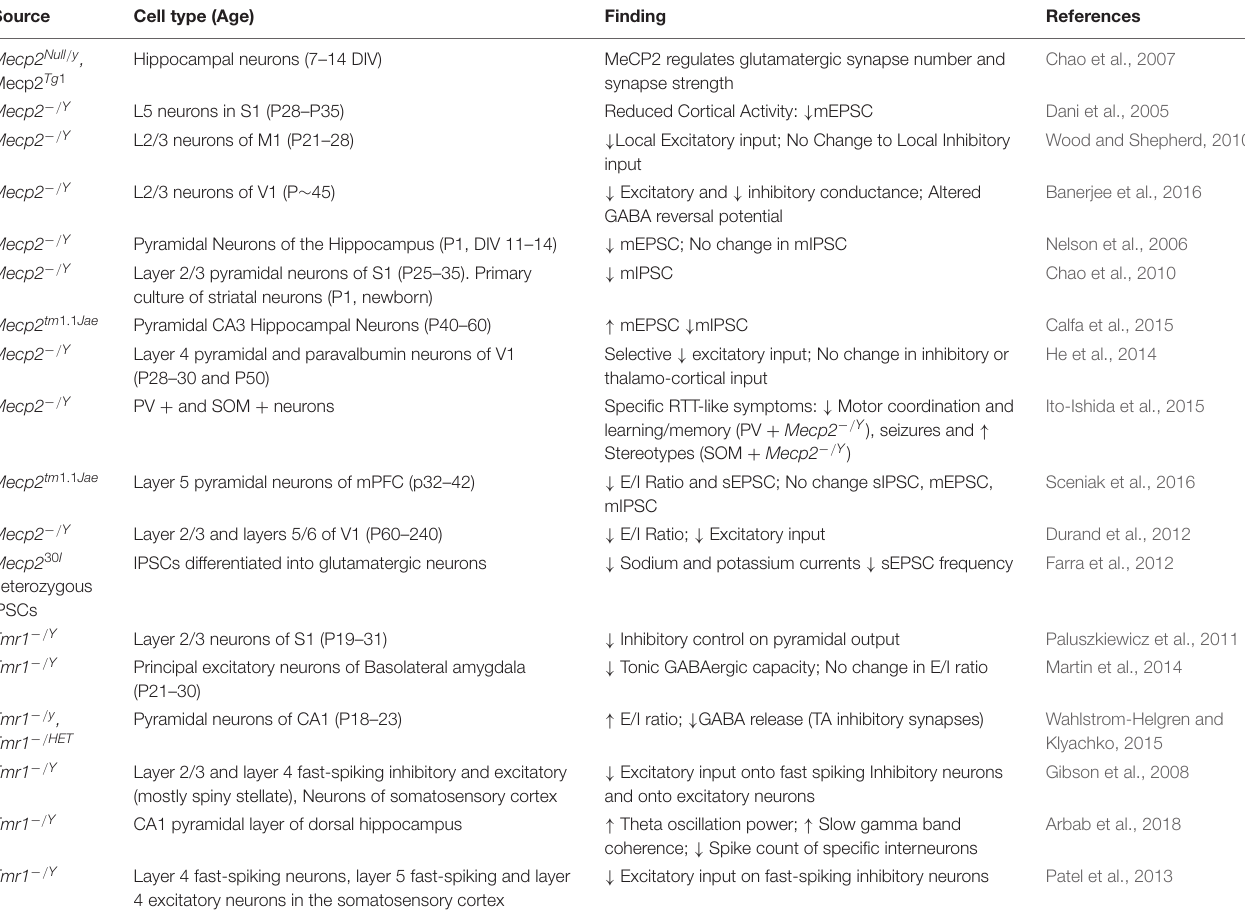
TABLE 1 | Altered synaptic function in Rett syndrome and Fragile X